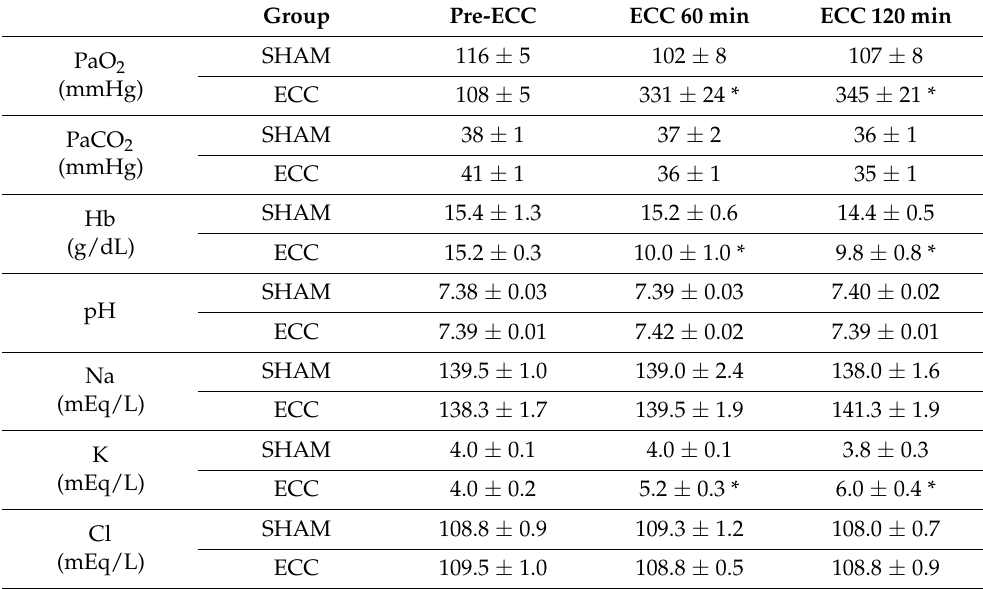
Figure 2. Hemodynamic changes (heart rate and mean blood pressure). * p < 0.05 versus SHAM group at the same time point. Table 1. Hemodynamic changes, Hb, partial pressure of blood gas, and electrolyte levels before and during ECC.